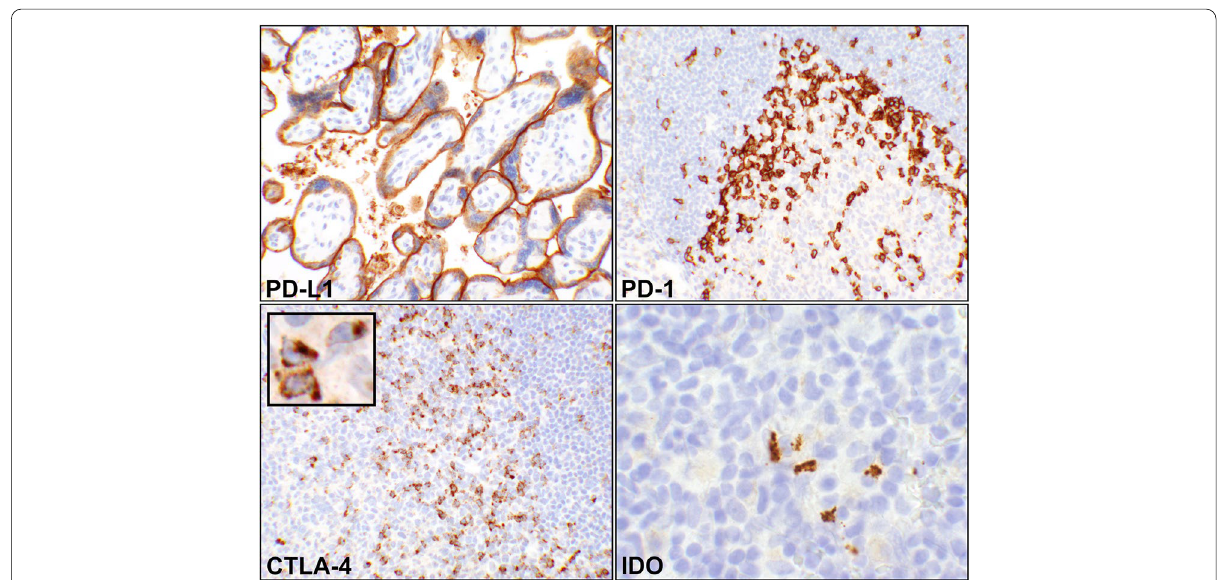
Fig. 1 Controls for the immunohistochemical (IHC) reactions. (PD-L1) A photomicrograph showing intense predominant staining of syncytiotrophoblasts appearing as a linear reaction. Tonsils can be also used as control for this immune checkpoint (20 portion a lymphoid follicle in tonsil with adjacent germinal center depicting T-helper cells by IHC (20 of the cells. (CTLA-4), Photomicrograph of a segment of a tonsillar germinal center with the adjacent follicular cell (20 the activated T-cells where the reactions are coarsely granular and intracytoplasmic (inset, 60 tonsillar lymphoid tissue showing a few dendritic cells with granular intracytoplasmic reaction